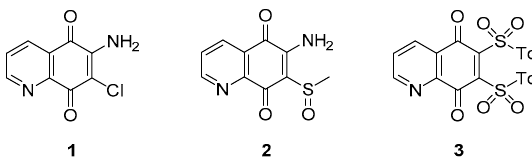
Figure 5. Chemical structures of compounds 1–3.